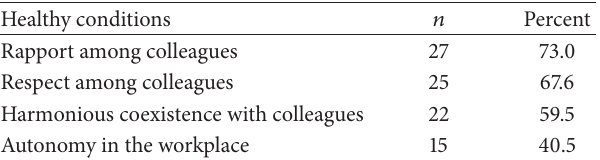
Table 5: Working conditions that promote well-being for teachers at